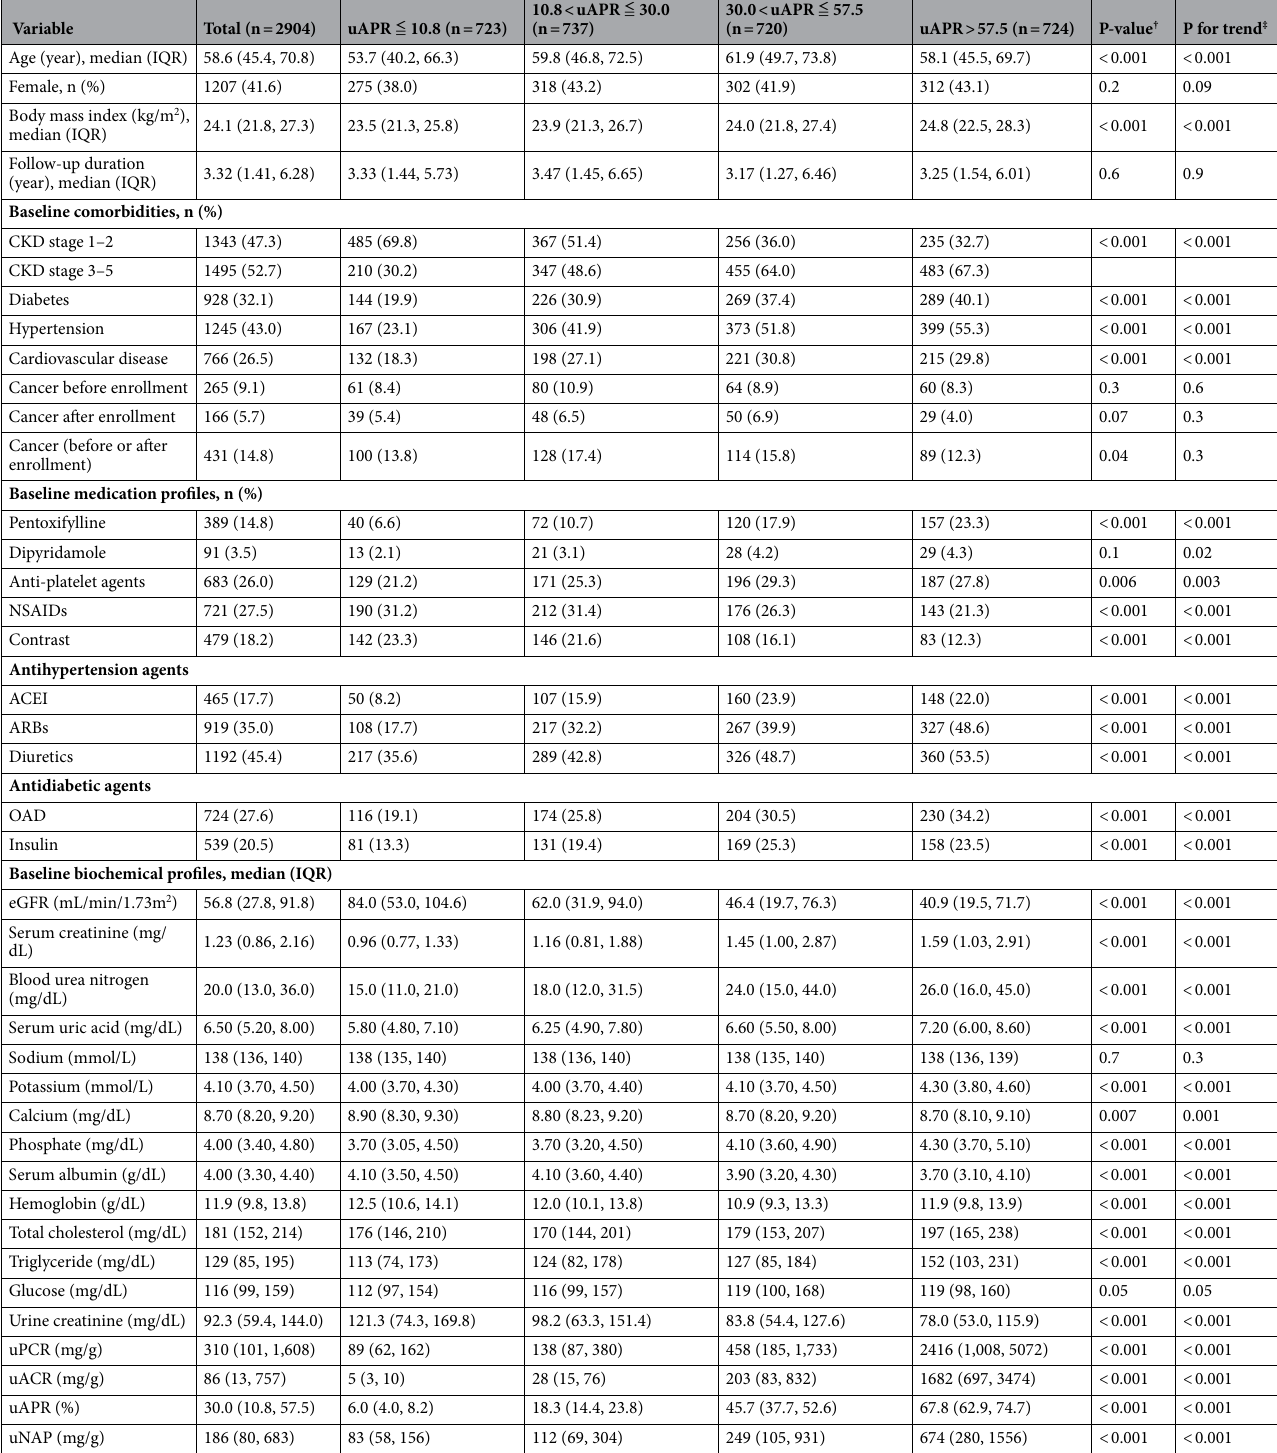
Table 2. Baseline demographic and clinical characteristics stratified by quartiles of urine albumin-to-protein ratio (uAPR). ACEI angiotensin-converting-enzyme inhibitors, ARBs angiotensin receptor blockers, CKD